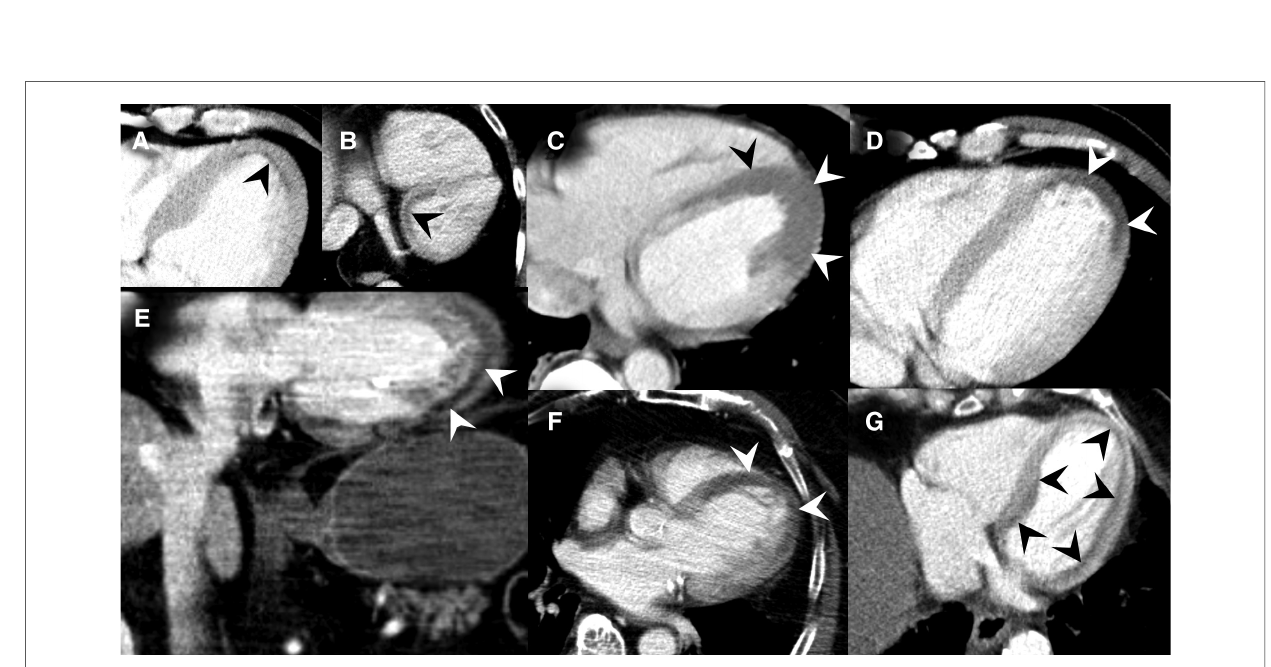
FIGURE 7 Collection of MDCT images of patients with MH (black and white arrowheads) caused by acute MI. ( A ) Slight subendocardial perfusion de fi cit at the heart apex. ( B ) Coronal slice through the heart base showing predominately subendocardial MH. ( C ) Extensive MH at the left ventricle. ( D ) Coronal reformats with impressive MH at the cardiac apex. ( E ) Axial MDCT slices demonstrating MH at the cardiac apex. ( F ) Subendocardial MH along the entire left ventricle.